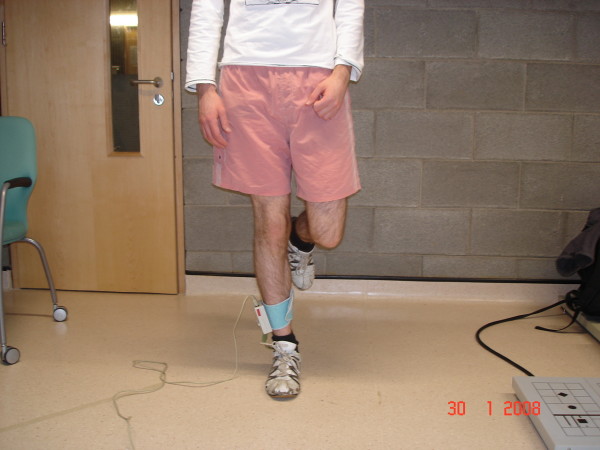
Insole calibration.